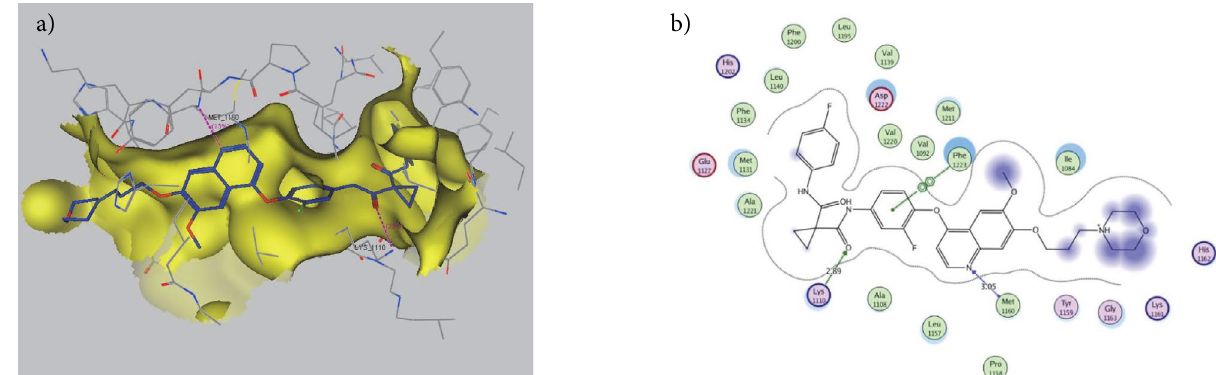
Figure 2. Interactions of XL880 (foretinib) with the amino acid residues of the active site of c-Met 3D(a) and 2D(b)